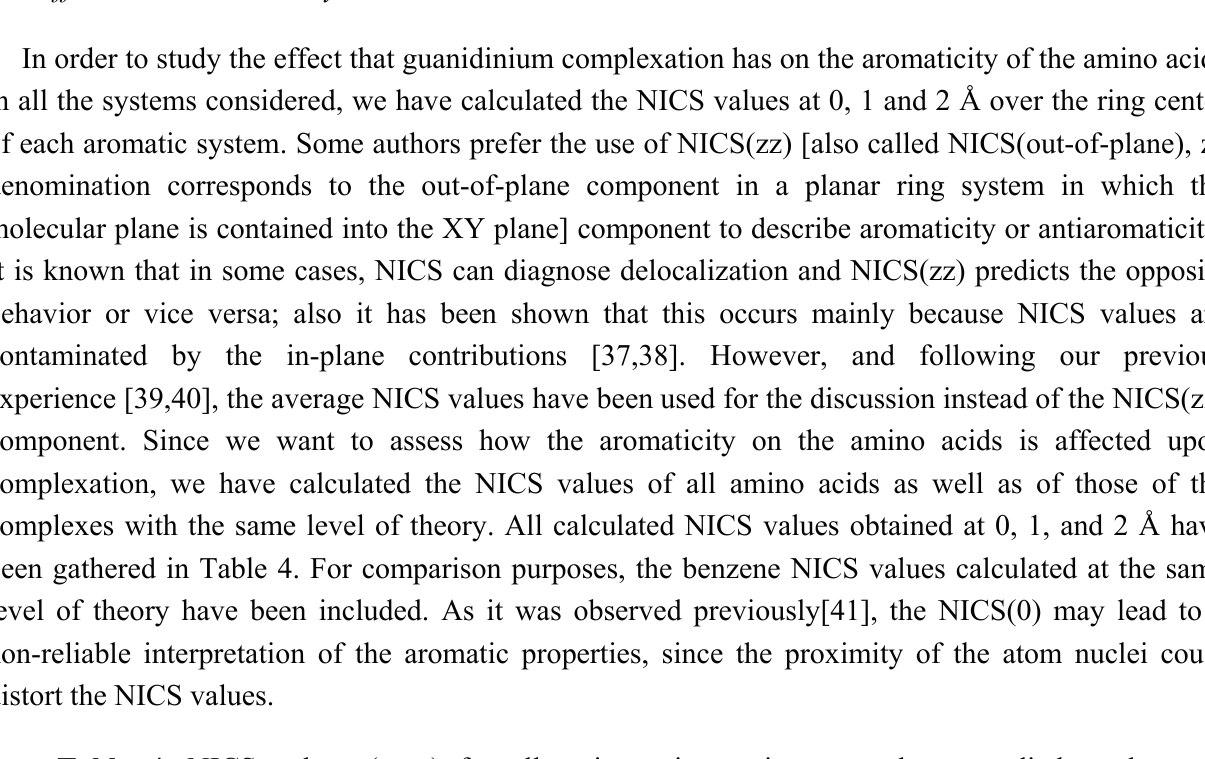
Table 4. NICS values (ppm) for all cation- π interactions complexes studied at the for five member ring for Trp and its